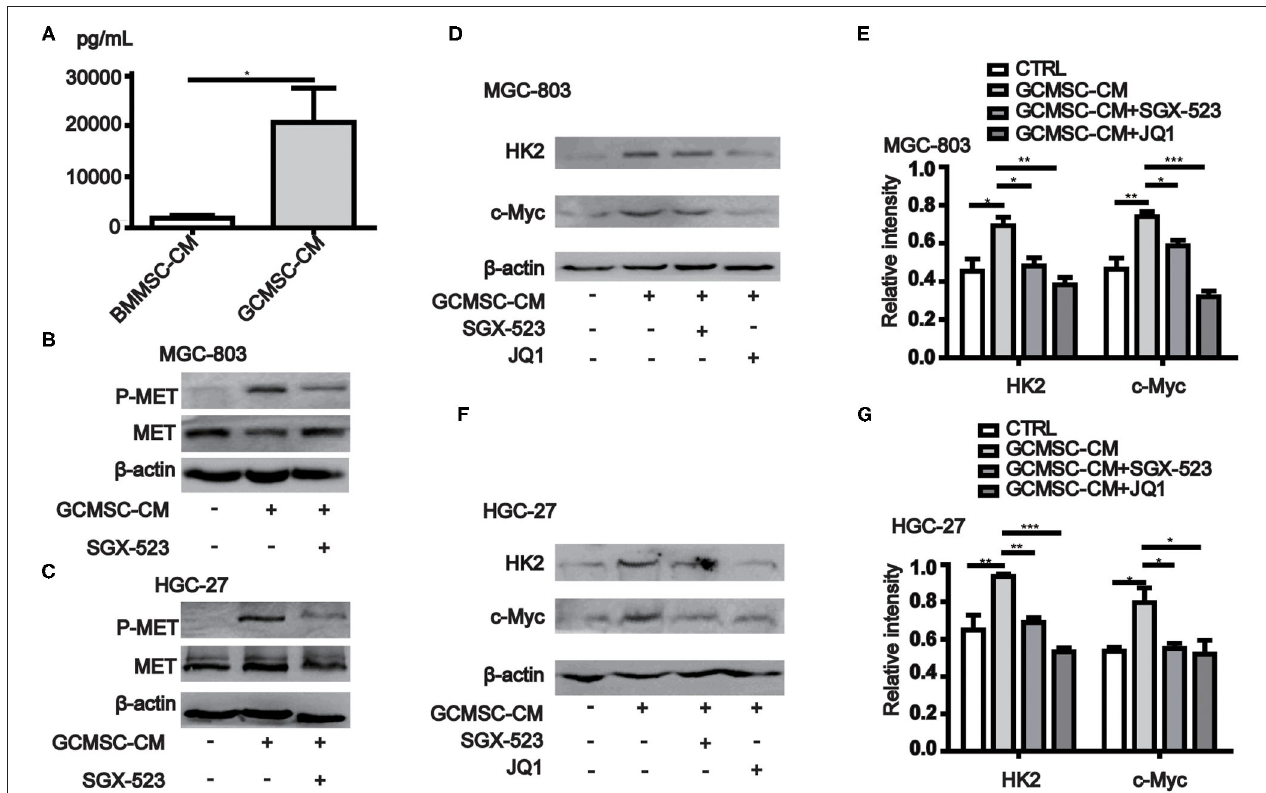
FIGURE 3 | GCMSCs-derived HGF promotes HK2 expression by regulating c-Myc. (A) ELISA analysis of the HGF expression in BMMSC-CM and GCMSC-CM. (B) Immunoblotting of p-MET, total MET in MGC-803 cells treated with GCMSC-CM or GCMSC-CM + SGX-523 (4nM) for 30min. (C) Immunoblotting of p-MET, total MET in HGC-27 cells treated with GCMSC-CM or GCMSC-CM + SGX-523 (4nM) for 30min. (D) Immunoblotting of HK2 and c-Myc in MGC-803 cells treated with GCMSC-CM, GCMSC-CM + SGX-523 (4nM), or GCMSC-CM + JQ1 (0.8 µ M) for 48h. (E) Quantitative statistics of the c-Myc and HK2 expression in MGC-803 cells. (F) Immunoblotting of HK2 and c-Myc in HGC-27 cells treated with GCMSC-CM, GCMSC-CM + SGX-523 (4nM), or GCMSC-CM + JQ1 (0.8 µ M) for 48h. (G) Quantitative statistics of the c-Myc and HK2 expression in HGC-27 cells ( n = 3; * P < 0.05; ** P < 0.01; *** P < 0.001).